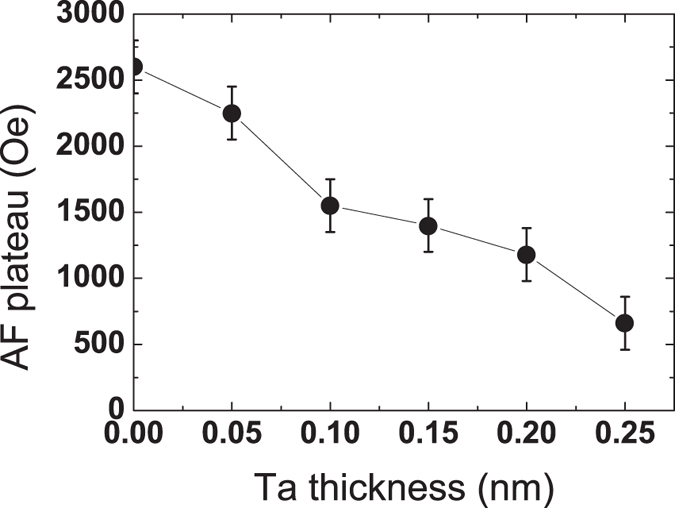
RKKY coupling as a function of Ta thickness in SAF2.Variation of the width of the antiparallel plateau for SAF1/SAF2 junctions as a function of Ta insertion thickness, where SAF2 is FeCoB1.4/Tax/Ruy/FeCoB1.1. y is adjusted to keep the maximum coupling amplitude.